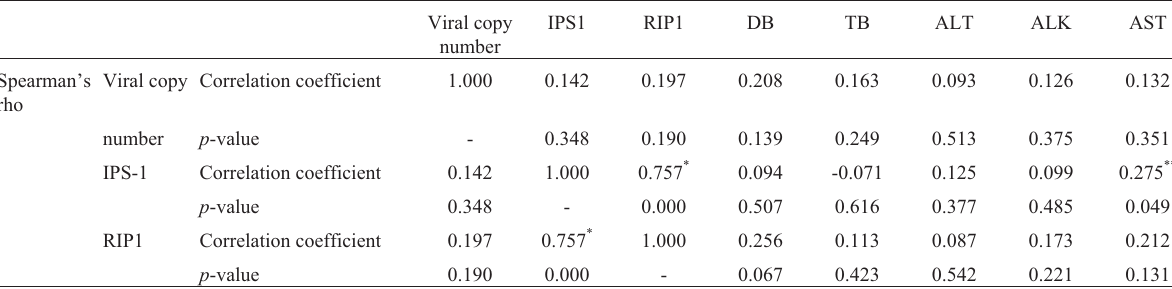
Table 2 - Associations of IPS-1 and RIP1 genes with serum levels of liver